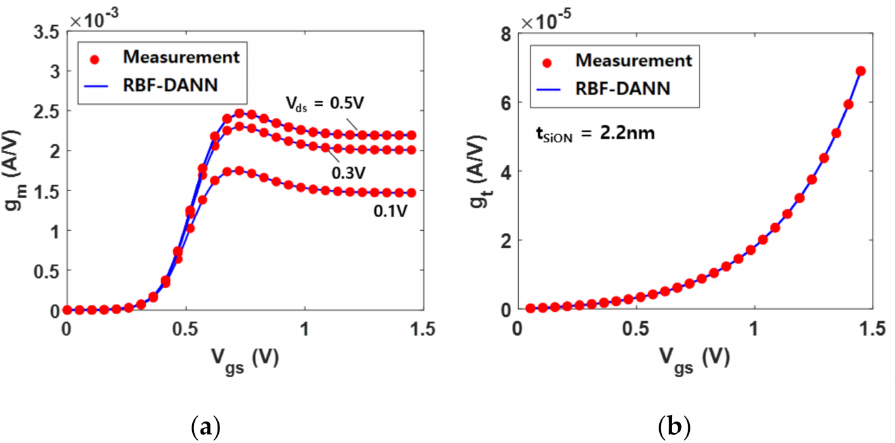
Figure 4. Comparison of measured data with the results obtained using the RBF-DANN (radial basis function-differential artificial neural networks) model for ( a ) the drain transconductance g m and ( b ) the gate tunnelling conductance g t